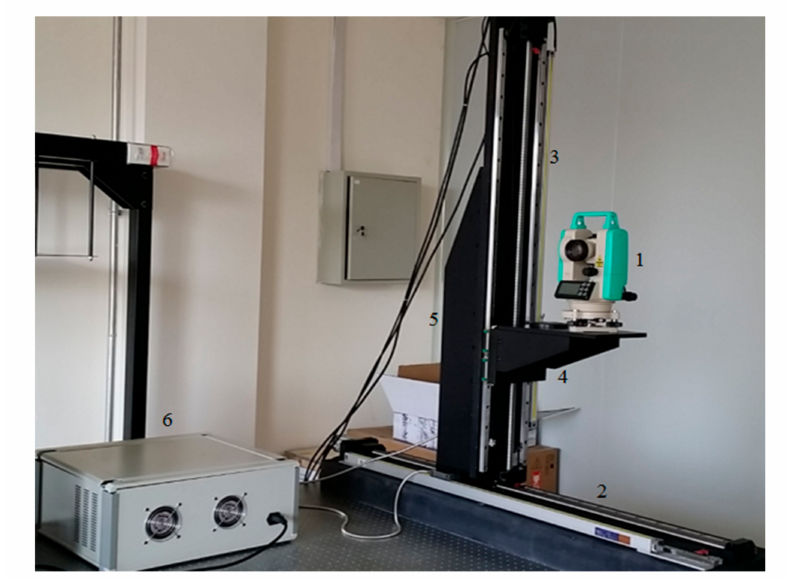
Figure 8. The ultra-high precision camera calibration